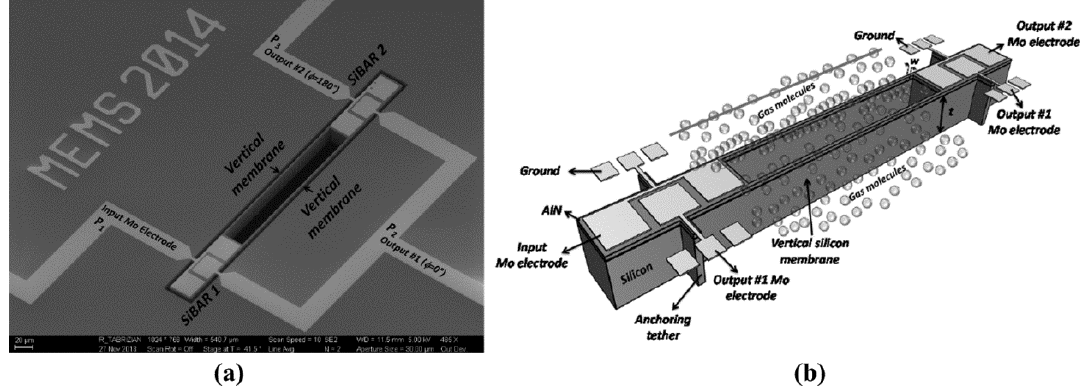
Figure 16. ( a ) SEM photo of device; ( b ) Schematic view of WCRB sensor for pressure measurement. Reproduced with permission from [111]. Copyright © 2014, IEEE.